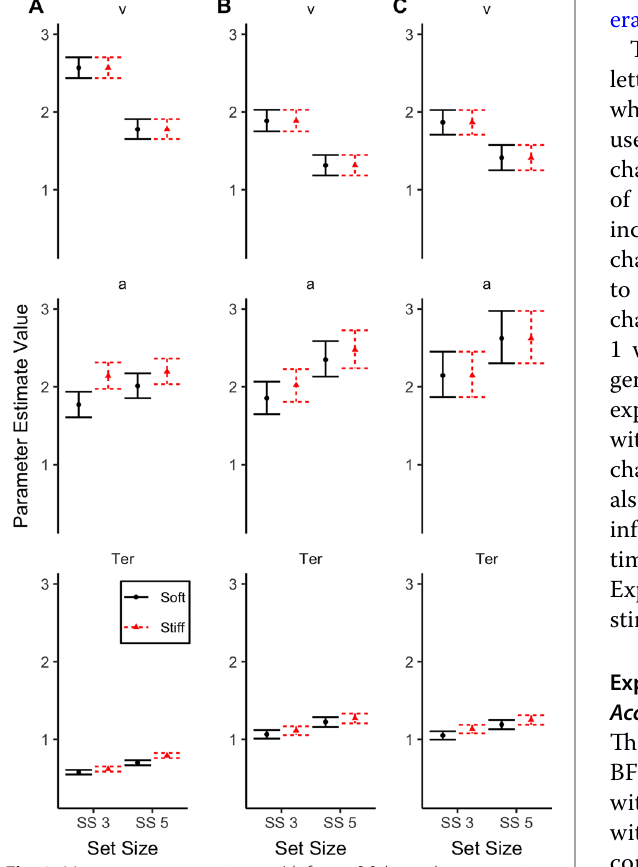
Fig. 3 Mean parameter estimates (drift rate [ v ], boundary separation [ a ] and non-decision time [ Ter ]) for Experiment 1 model 4 ( A ) and Experiment 2 model 4 ( B ) and model 5 ( C ). SS set size. Error bars are 95% credible